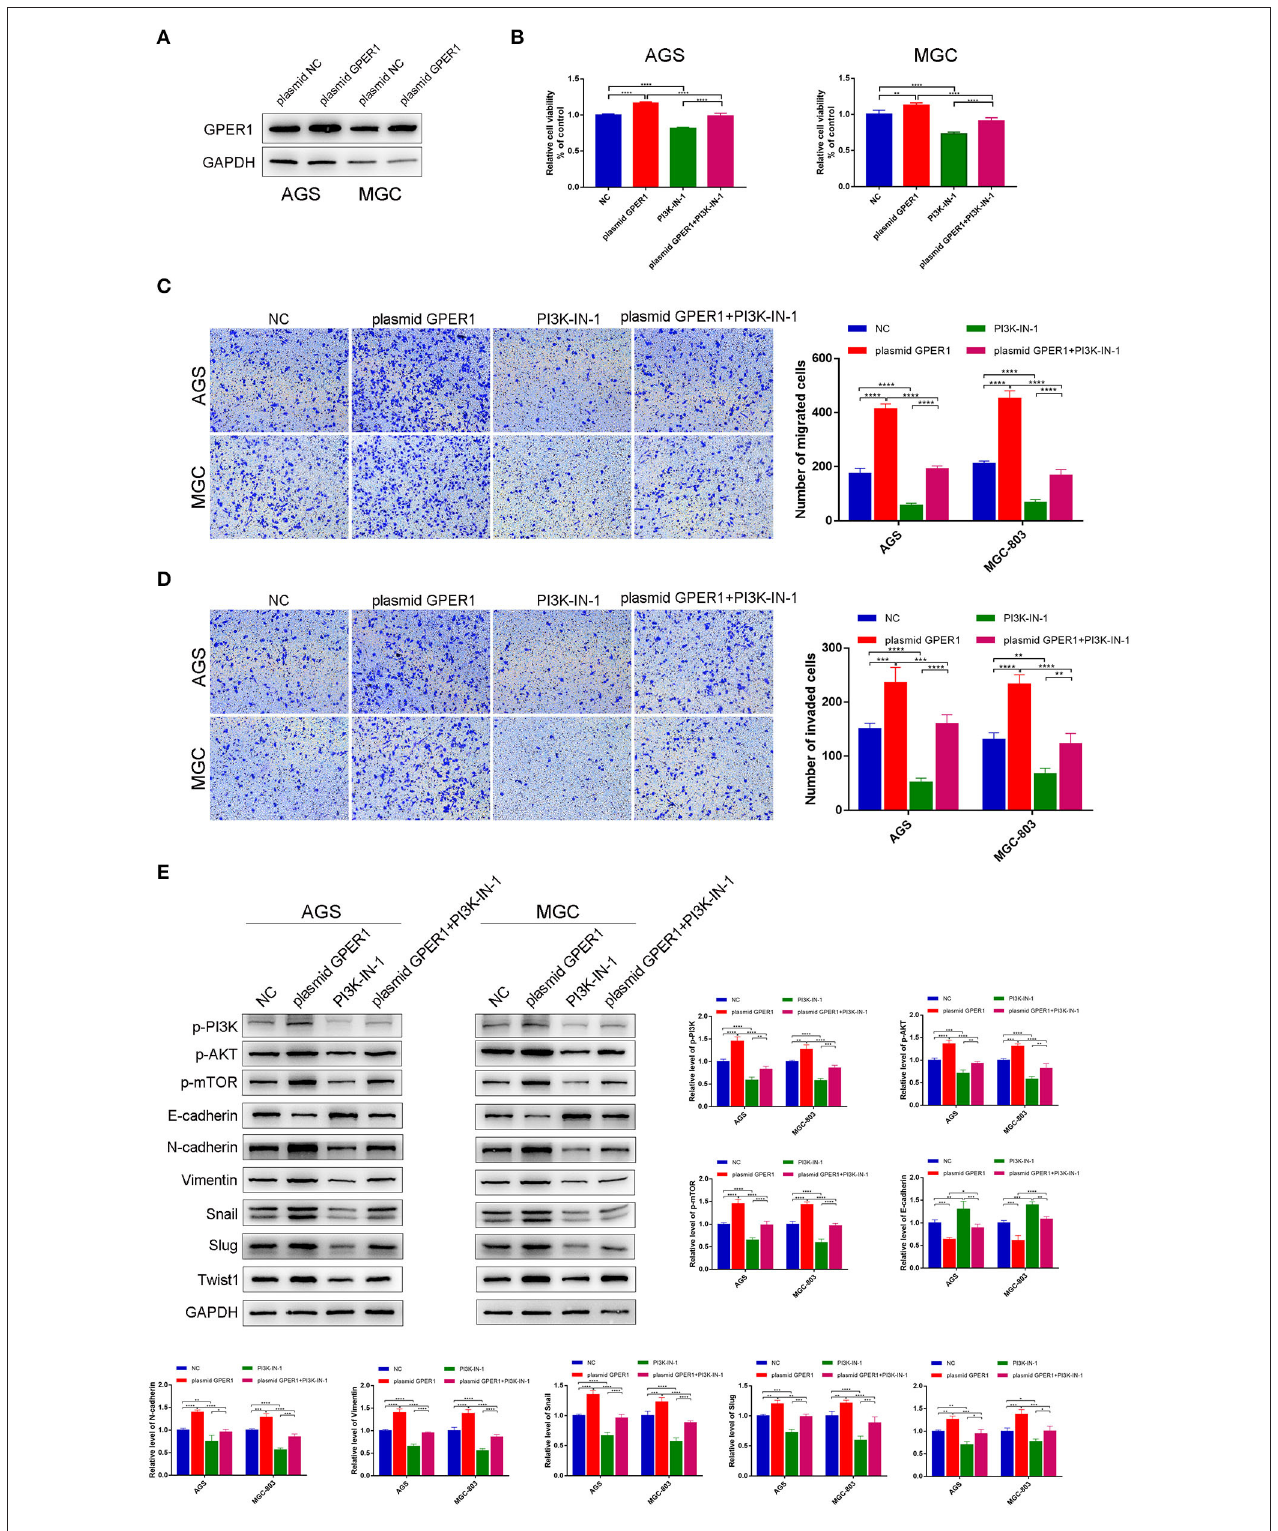
FIGURE 6 | Overexpression of GPER1 promotes proliferation, migration, and invasion of gastric cancer cells. (A) Protein levels of GPER1 in AGS and MGC-802 cells transfected with plasmid targeting GPER1; (B) CCK-8 was used to evaluate the proliferation of AGS and MGC-803 cells after transfection with GPER1 plasmid for 48h; (C) cell migration and (D) invasion were detected by transwell assays; (E) . Western blot analysis of PI3k pathway and EMT markers were detected. * P < 0.05; ** P < 0.01; *** P < 0.001; **** P < 0.0001.